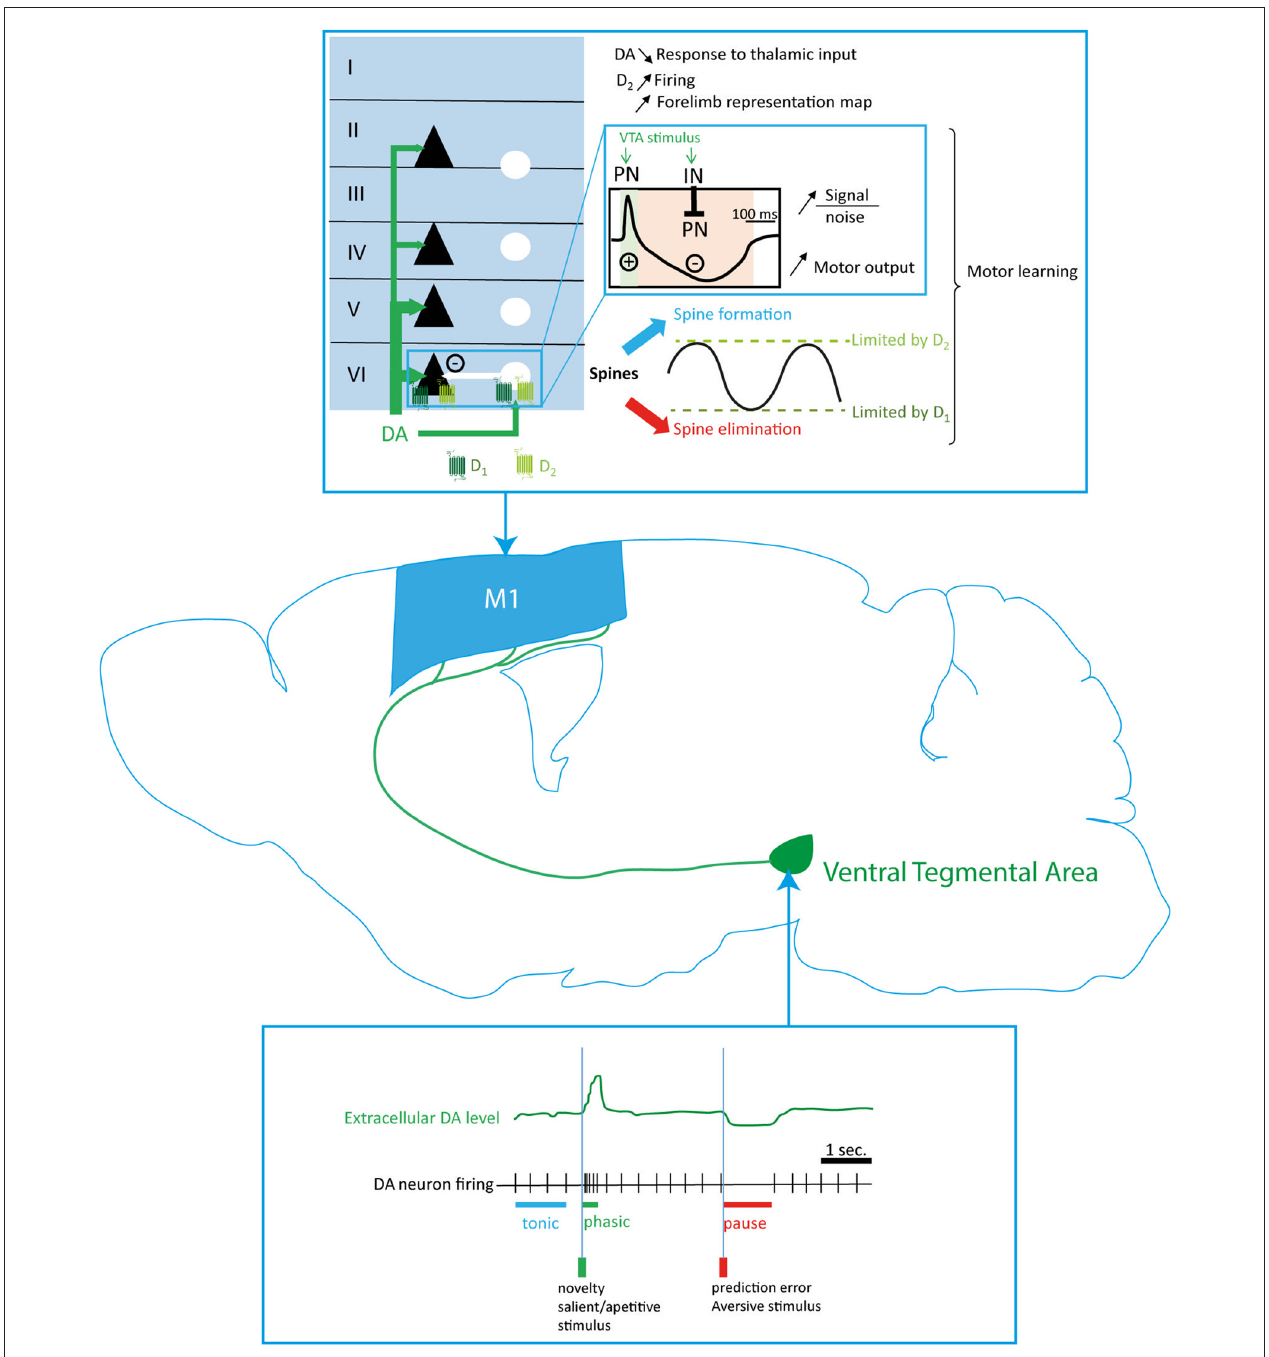
FIGURE 2 | Dopaminergic modulation of the motor cortex function. Dopaminergic innervation of M1 originates in the ventral tegmental area (VTA; green arrows) and preferentially innervates the deep motor cortical layers. Phasic and tonic firing of dopaminergic neurons regulate the dopamine (DA) level in the motor cortex and activate respectively D1 and D2 which are thought to be expressed by the PNs (black triangles) and the INs (white circles) in the motor cortex. Thus, DA innervation exerts a biphasic modulation (blue inlay) of motor cortex neurons to promote motor outputs, increase the signal to noise ratio and regulate the spine turnover necessary to the expression of plasticity and motor learning. DA, dopamine; PN, pyramidal neuron; IN, interneuron.